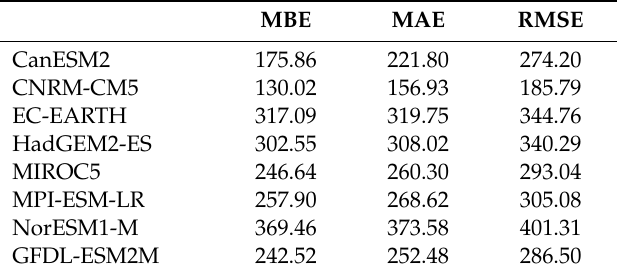
Figure 7. Second quarter total rainfall evolution. Table 10. Results of statistical criteria for second quarter total precipitation.